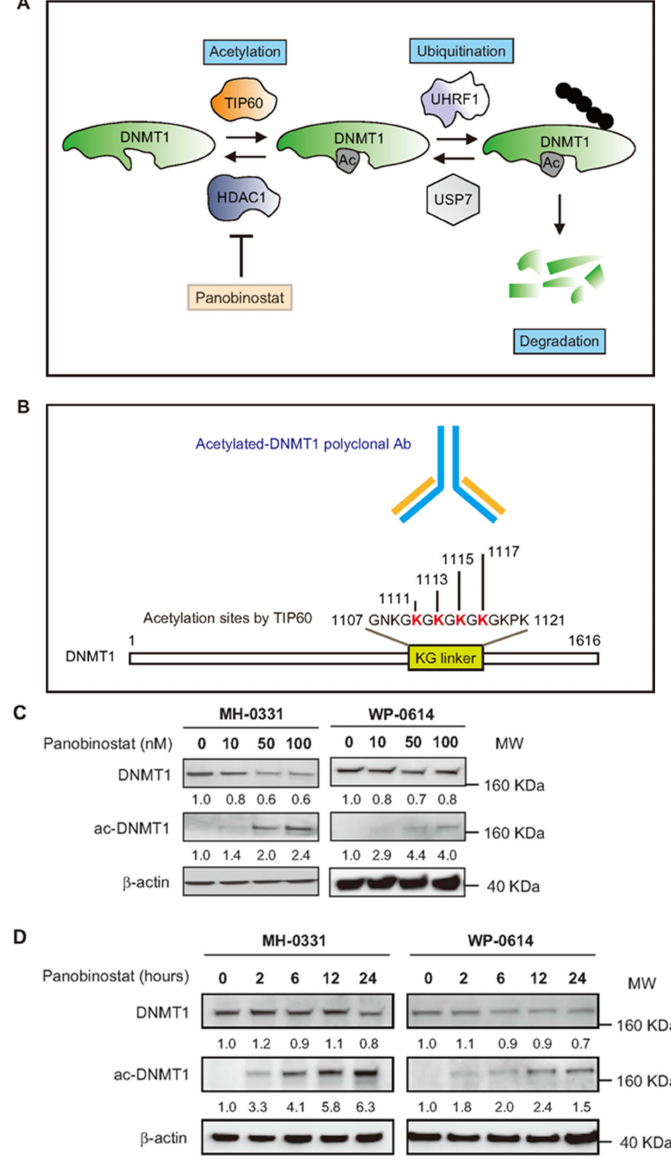
Figure 2. Molecular mechanisms controlling DNMT1 PTMs and protein stability. ( A ) Schematic diagram showing the acetylation process that modulates the stability of DNMT1 protein. ( B ) The ac-DNMT1 Ab recognizes the four acetylated lysine residues located in the KG linker of the DNMT1 protein domain. ( C , D ) Western blot of DNMT1 and ac-DNMT1 in metastatic melanoma cells treated with different concentrations (10, 50, and 100 nM) of panobinostat for 24 h ( C ) or treated with 100 nM panobinostat ( D ) for the indicated times (2, 6, 12, and 24 h). β -actin was used as the loading